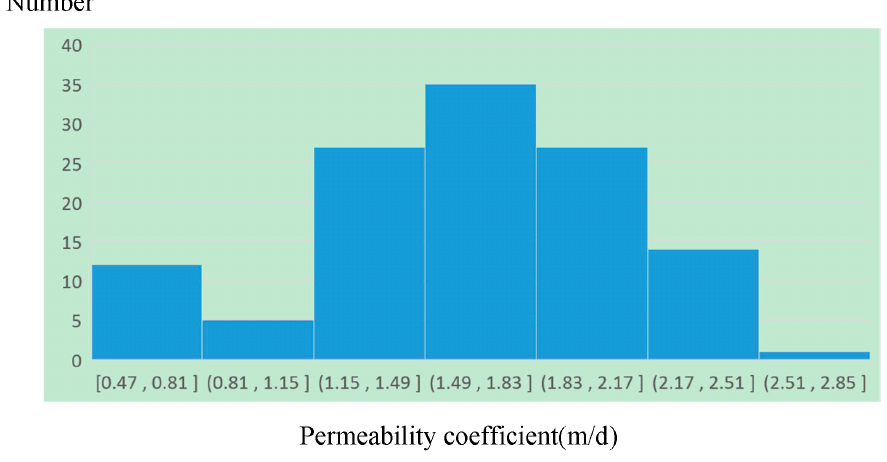
Figure 5. Histogram of fine sediment permeability coefficient.